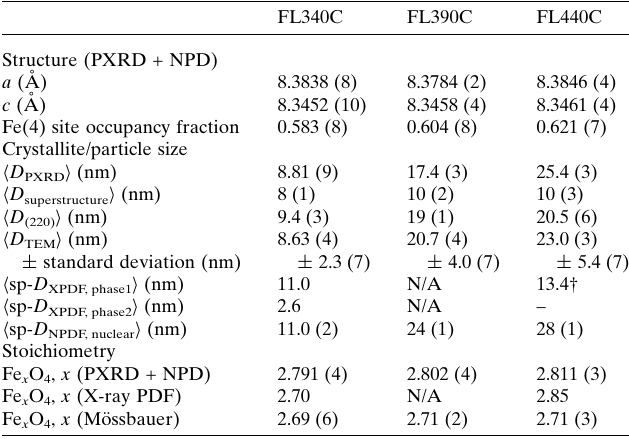
Table 2 The main results from combined Rietveld refinements of PXRD and NPD data along with size analyses and obtained stoichiometries from various techniques. The Rietveld refinements and PDF analyses were carried out based on the atomic structure in space group P 4 3 2 1 2 with full occupancy on all other sites than Fe 4 a . sp- D = refined spherical particle diameter, XPDF = X-ray PDF, NPDF = neutron PDF.